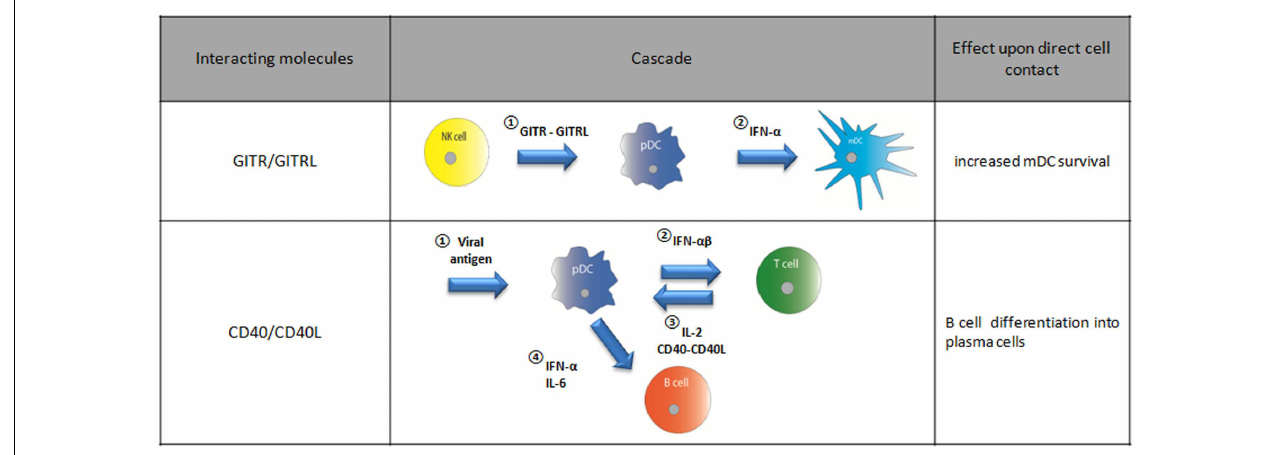
FIGURE 8 | Direct cell interaction dependent on GITR/GITRL or CD40/CD40L binding and their effect on a certain cell type .